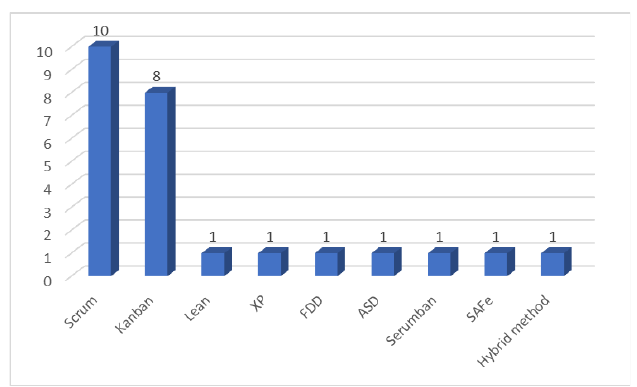
Fig. 4. Frequency of using agile development methods in the surveyed companies.